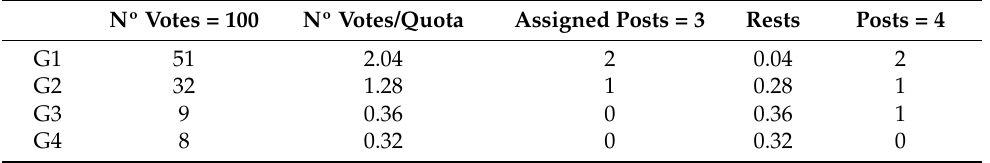
Table 5. Hamilton rule allocation table—example with four groups and 100 votes.